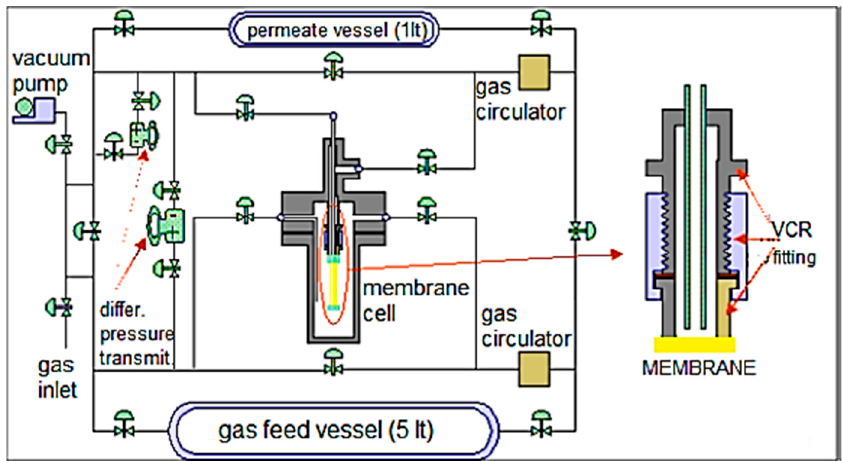
Figure 13. Gas permeability apparatus (operated from high vacuum up to 70 bar pressure condi- tions) [126]. Reproduced with permission from Elsevier.